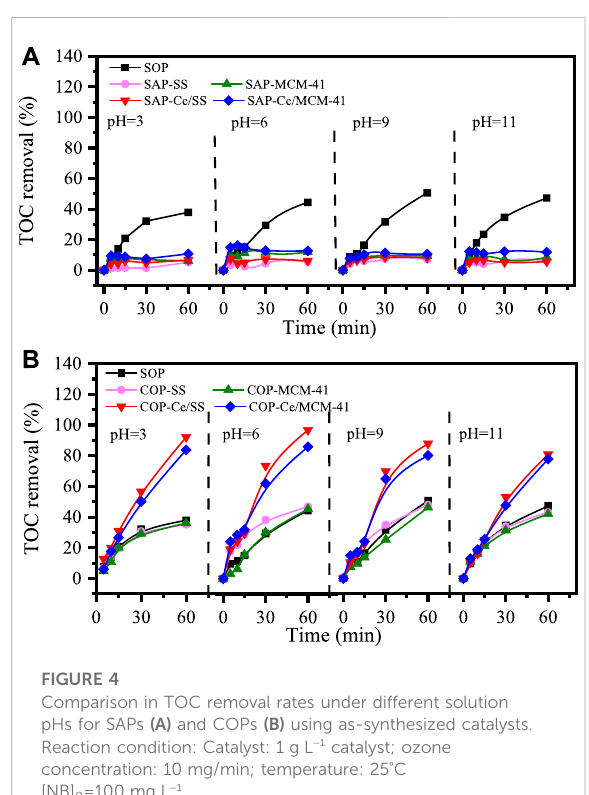
FIGURE 4 Comparison in TOC removal rates under different solution pHs for SAPs (A) and COPs (B) using as-synthesized catalysts. Reaction condition: Catalyst: 1 g L − 1 catalyst;